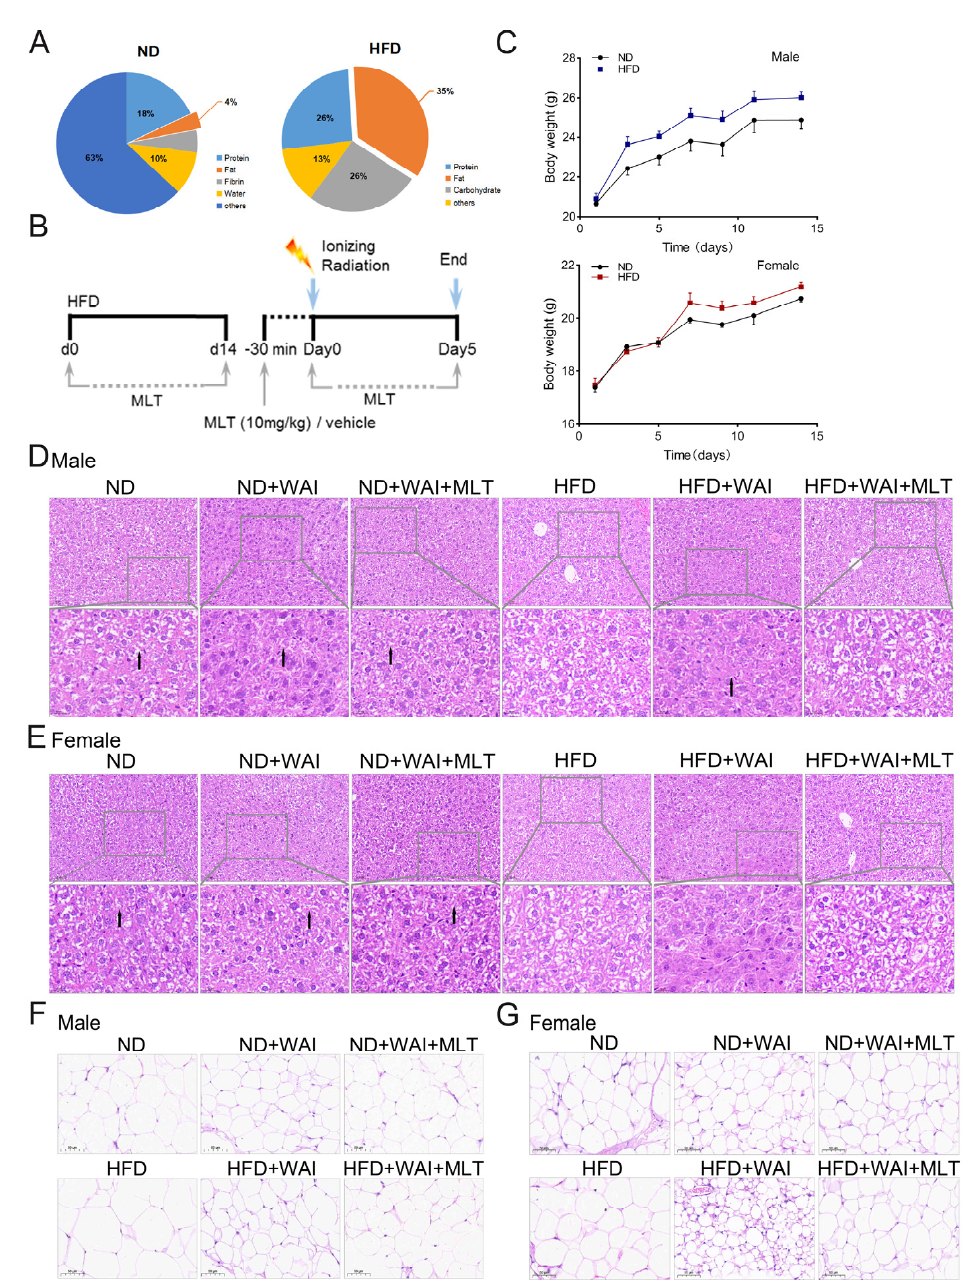
Figure 1. MLT reduces the damage of iWAT in mice induced by WAI. Mice were fed an HFD for 2 weeks, then given whole abdominal irradiation. MLT was injected intraperitoneally 30 min before WAI. Control mice received sham irradiation ( B ). ( A ) The fat content of a normal diet (ND) was 4%, whereas that of an HFD was 35%. ( C ) Body weights of ND-fed and HFD-fed mice. Representative H&E staining of hepatic lipids from male ( D ) and female ( E ) mice (20 × magnification); the black arrows indicate the perisinusoidal space. Representative H&E staining of iWAT from male ( F ) and female ( G ) mice (20 × magnification). (WAI, whole abdominal irradiation; HFD, high-fat diet; MLT, melatonin; H&E, hematoxylin and eosin).